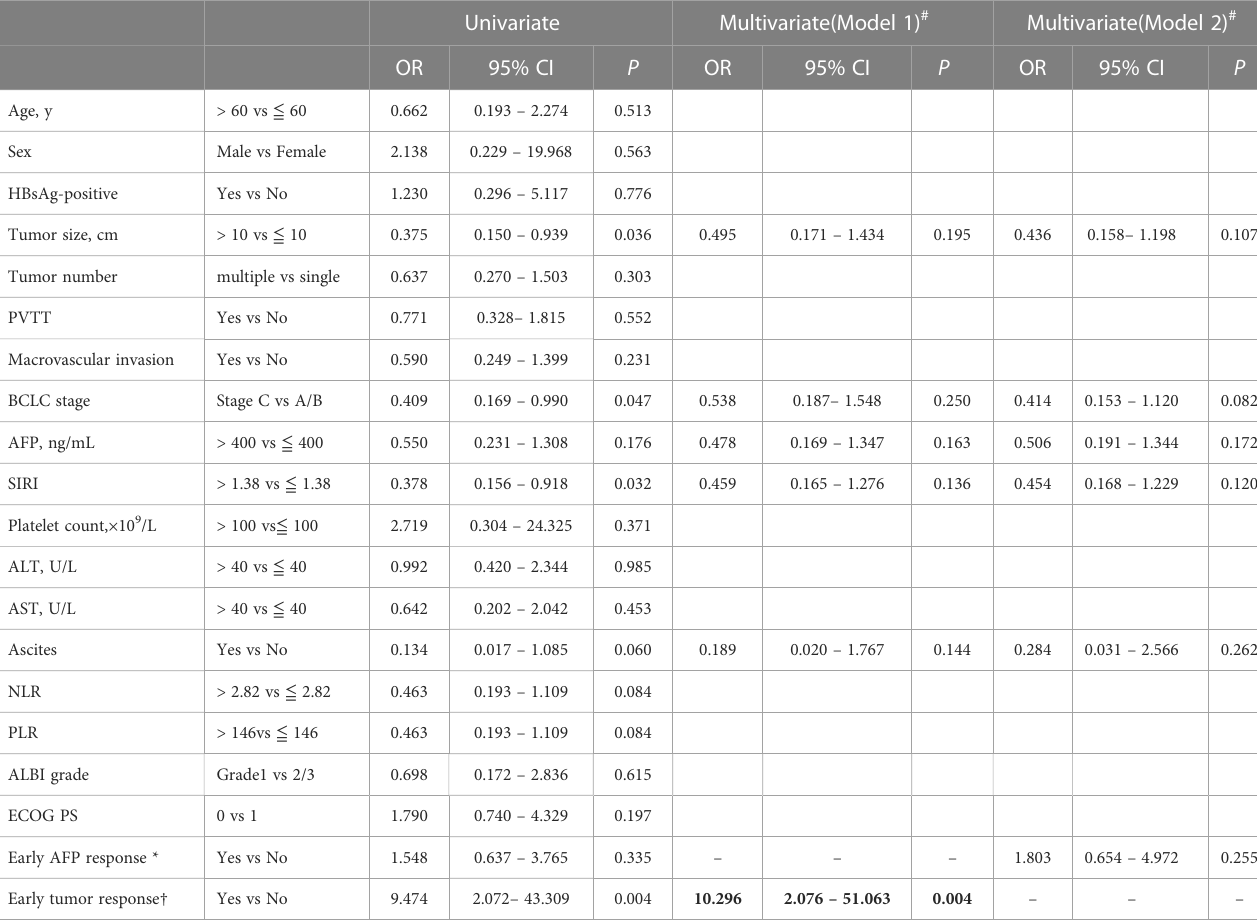
TABLE 3 Factors associated with successful conversion surgery in 94 patients who received conversion therapy for initially unresectable HCC.